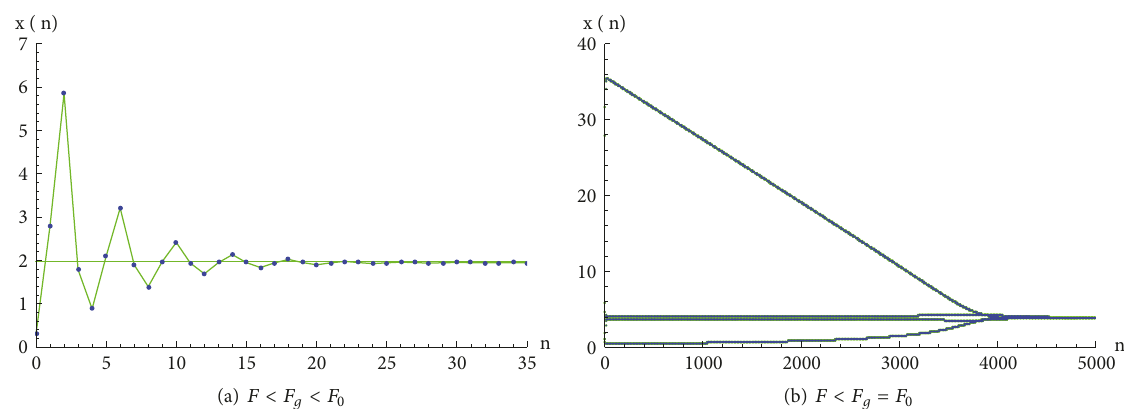
Figure 2: The orbit for (a) 𝑏 = 2 , 𝑐 = 1 , 𝐵 = 4 , 𝐹 = 7 , 𝐹 𝑔 = 8 , 𝐹 0 = 128 , and (𝑥 0 ,𝑥 −1 ) = (0.3,2.8) and (b) 𝑏 = 0.5 , 𝑐 = 0.5 , 𝐵 = 2 , 𝐹 = 30 , 𝐹 = 𝐹 = 32 , and (𝑥 , 𝑥 ) = (1.1,1) generated by Dynamica 4 𝑔 0 0 −1